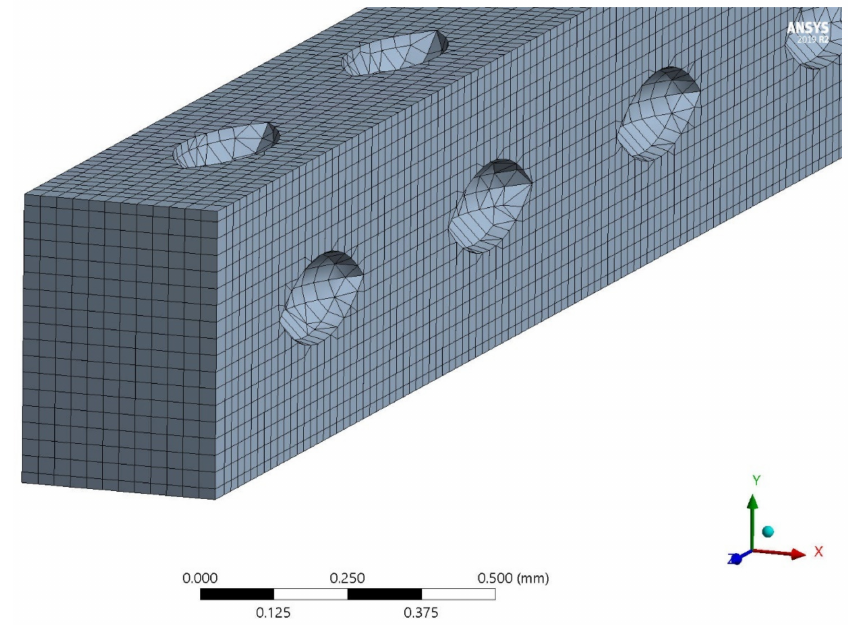
Figure 3. Grid for the solid domain of MCHS.